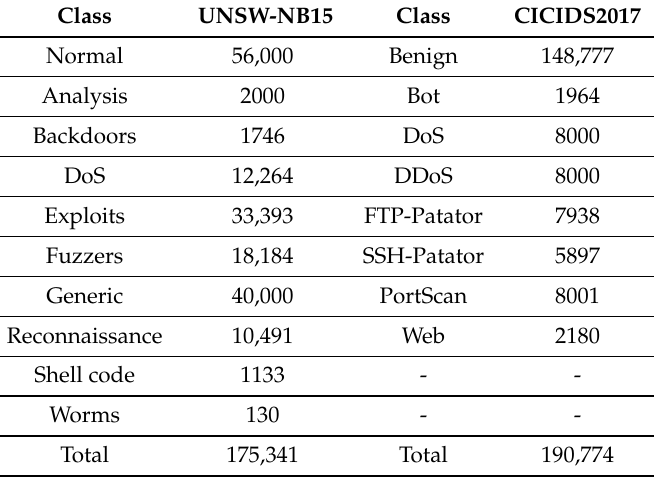
Table 2. Distribution of normal and attack samples of the UNSW-NB15 and CICIDS2017 datasets.